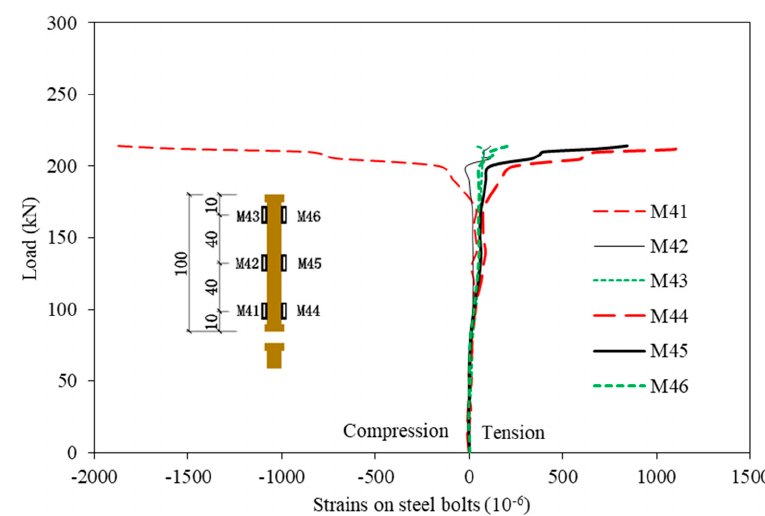
Figure 9. Load versus strain at the steel bolts.